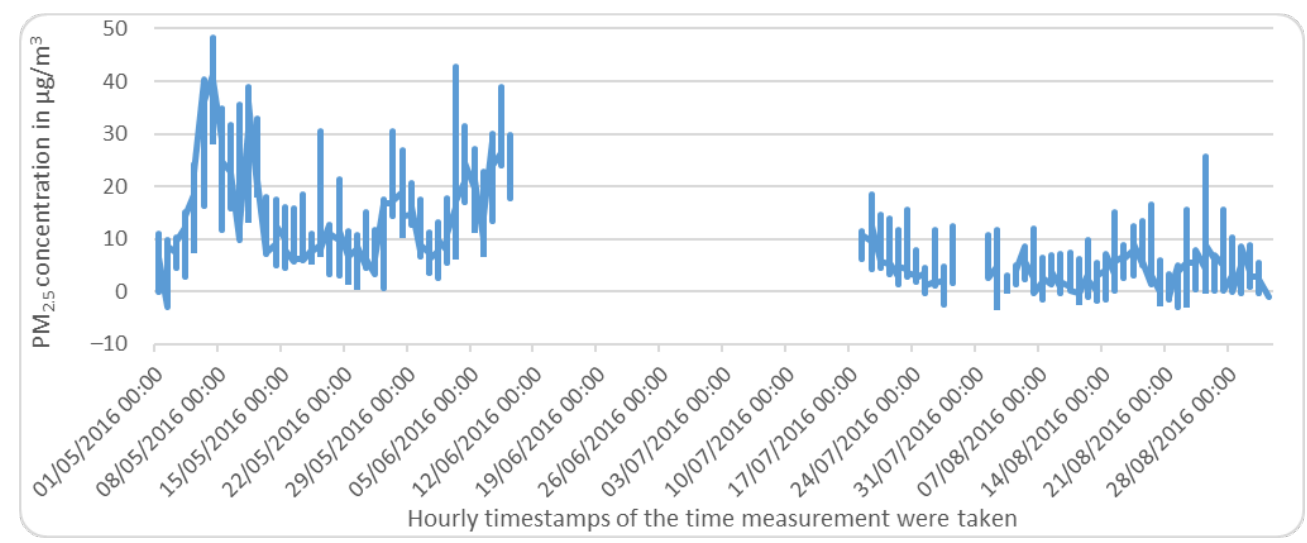
Figure 6. Sample of data from 1 May 2016 to 1 September 2016 data of Piccadilly station, Manchester, UK, before imputation.